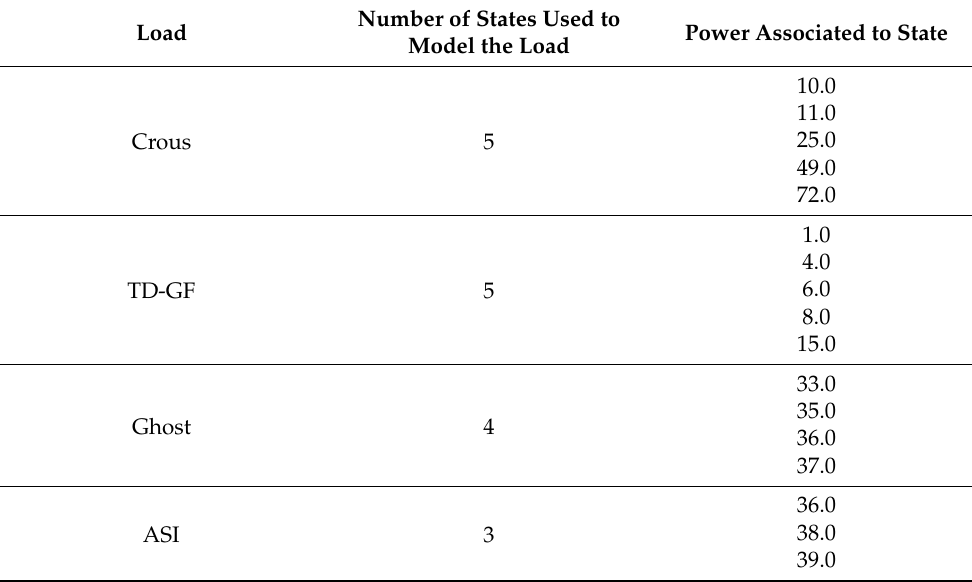
Table 4. Number of states used to model each load and power associated to